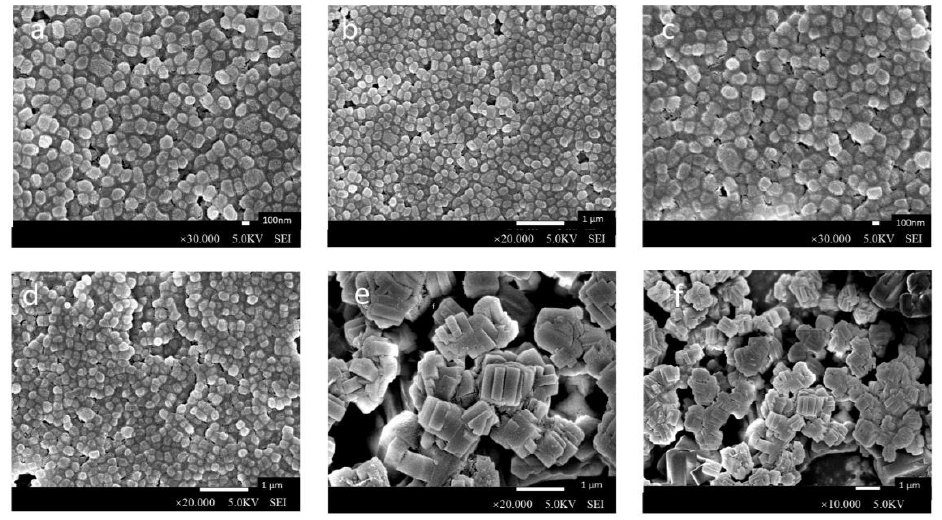
Figure 6. SEM images of TS-1 ( a , b ), TS-1 used four times ( c , d ), and commercial TS-1 ( e , f ).